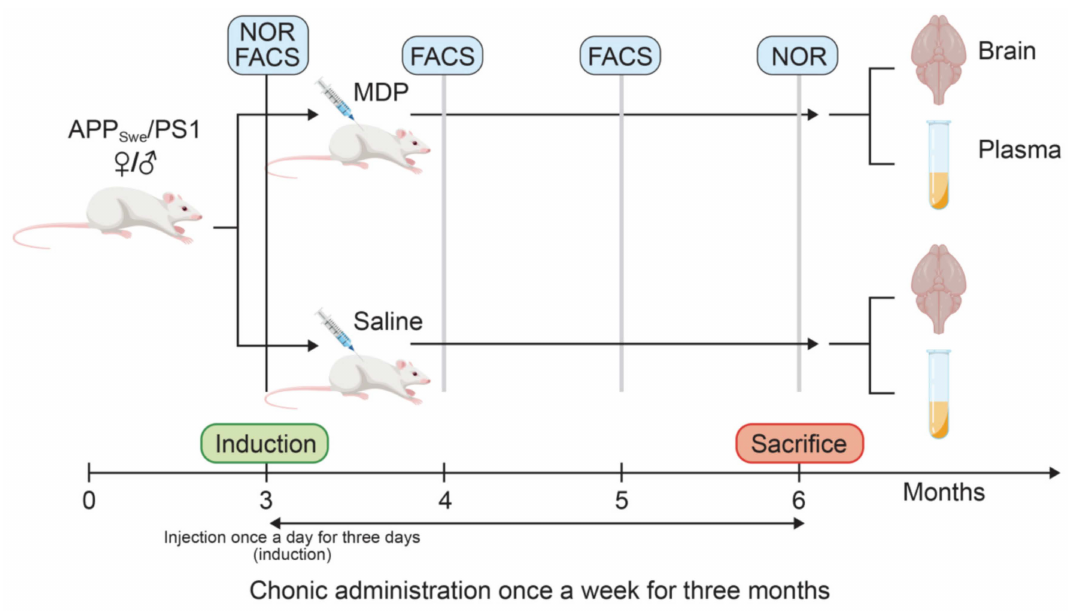
Figure 1. Timeline of the experimental design and methods following MDP (10 mg/kg) or saline (0.9%) administration in male or female wild-type and APP Swe /PS1 treated or not with MDP from 3 to 6 months old. Mice were injected once a day for three days (induction) followed by one injection a week for three months. At 6 months, the mice were sacrificed, and their brains and the plasma were extracted for further